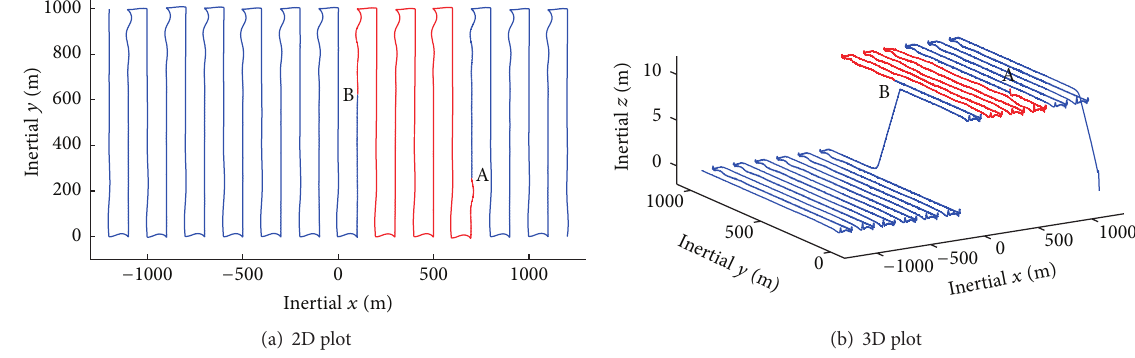
Figure 6: 2D and 3D plots under model-aided navigation from A to B.